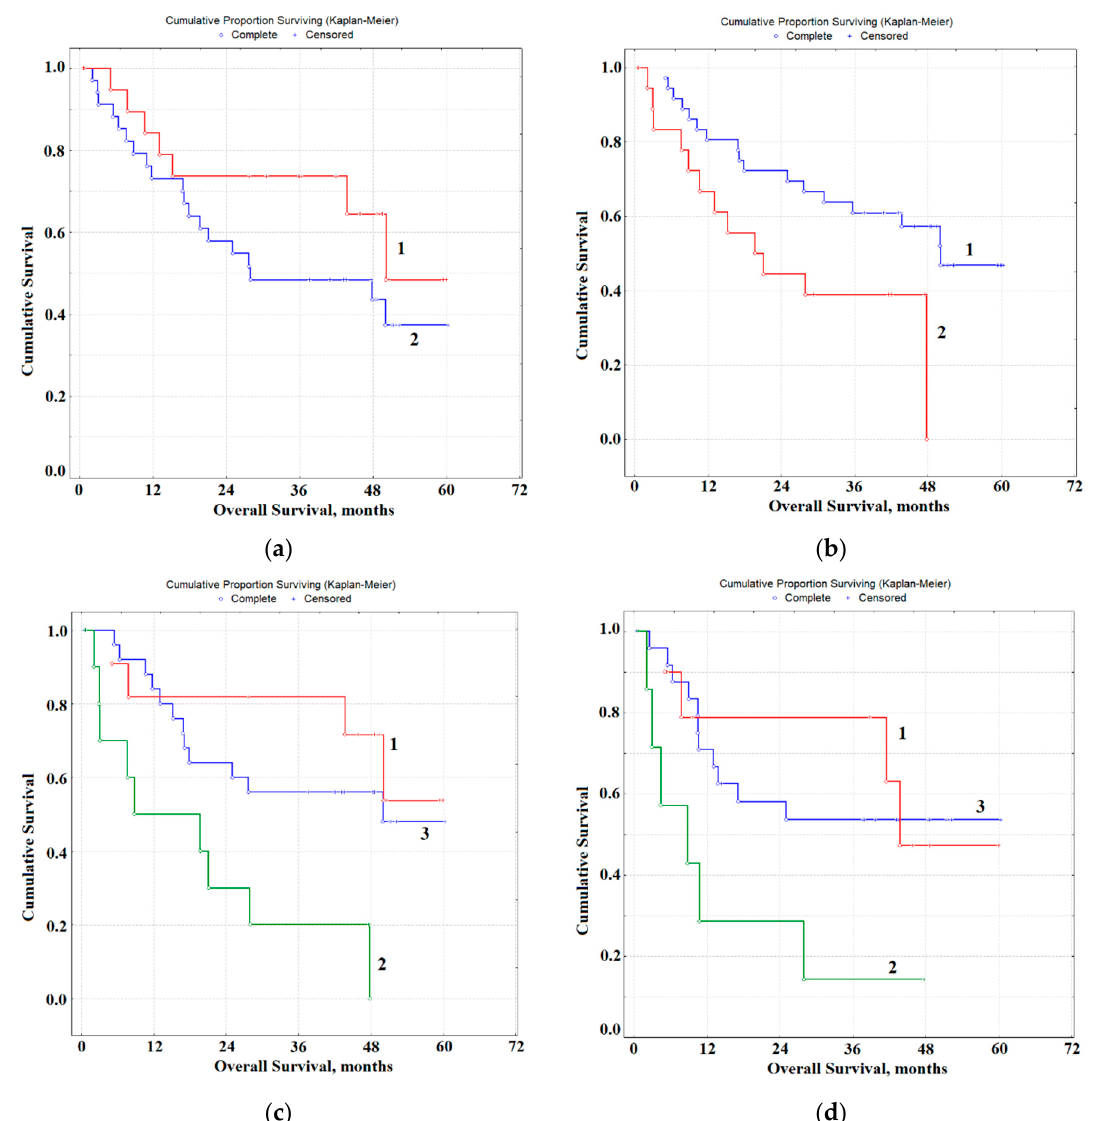
Figure 5. The overall survival of OSCC patients depending on the concentration of MDA and Na / K ratio in saliva: ( a ) MDA > 7.34 nmol / mL (curve 1) and MDA < 7.34 nmol / mL (curve 2); ( b ) Na / K < 1.09 c.u. (curve 1) and Na / K > 1.09 c.u. (curve 2); ( c ) multivariate regression analysis of overall survival: MDA > 7.34 nmol / mL and Na / K < 1.09 c.u. (curve 1); MDA < 7.34 nmol / mL and Na / K > 1.09 c.u. (curve 2); other combinations (curve 3); ( d ) multivariate regression analysis of the disease-free survival: MDA > 7.34 nmol / mL and Na / K < 1.09 c.u. (curve 1); MDA < 7.34 nmol / mL and Na / K > 1.09 c.u. (curve 2); other combinations (curve